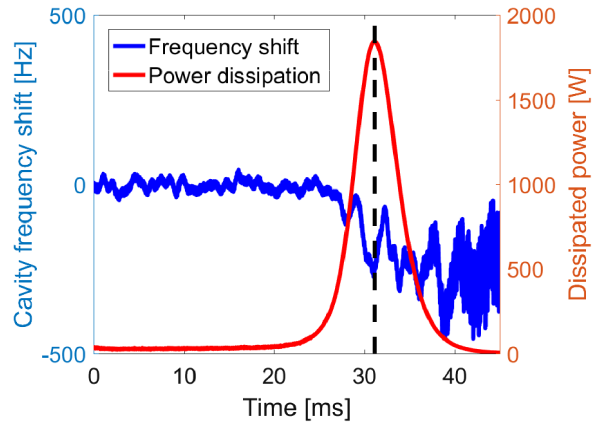
FIG. 4. Frequency shift with Lorentz force detuning subtracted (blue) and dissipated power (red) vs time in the DQW PoP crab cavity during a quench measurement at SM18,